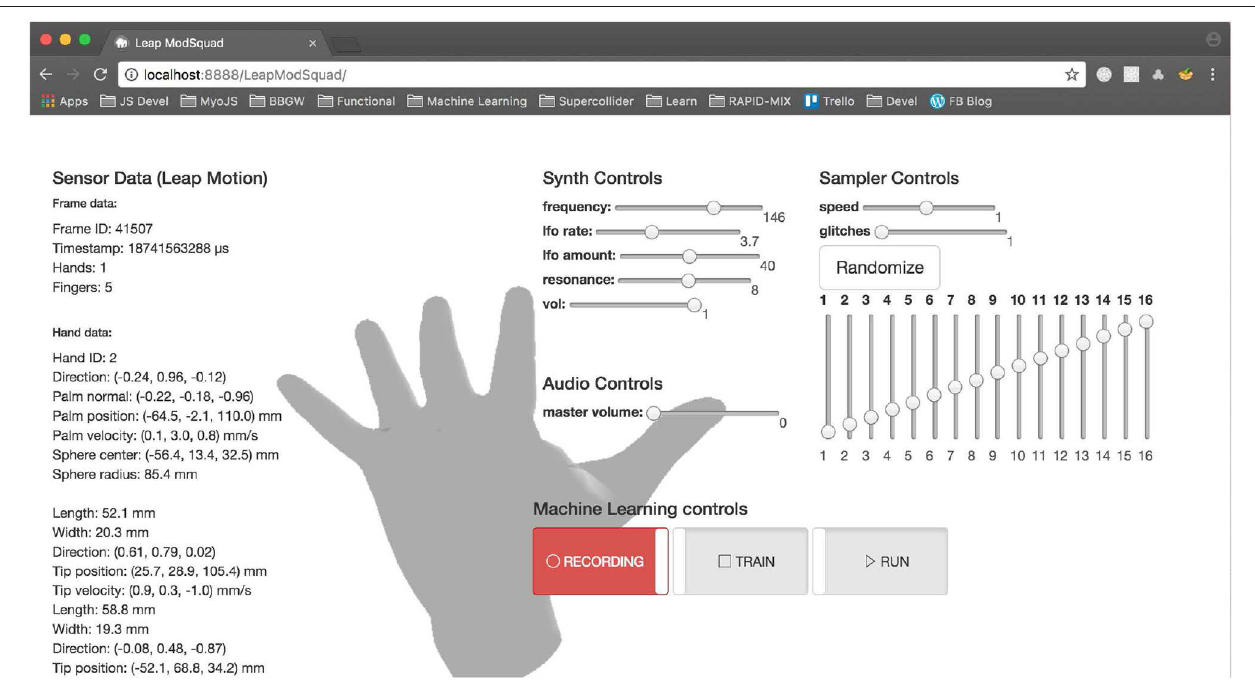
FIGURE 2 | RAPID-MIX API demonstrator for a regression model mapping Leap Motion sensor data streams to a multi-parametric browser-based sampler and synthesizer.